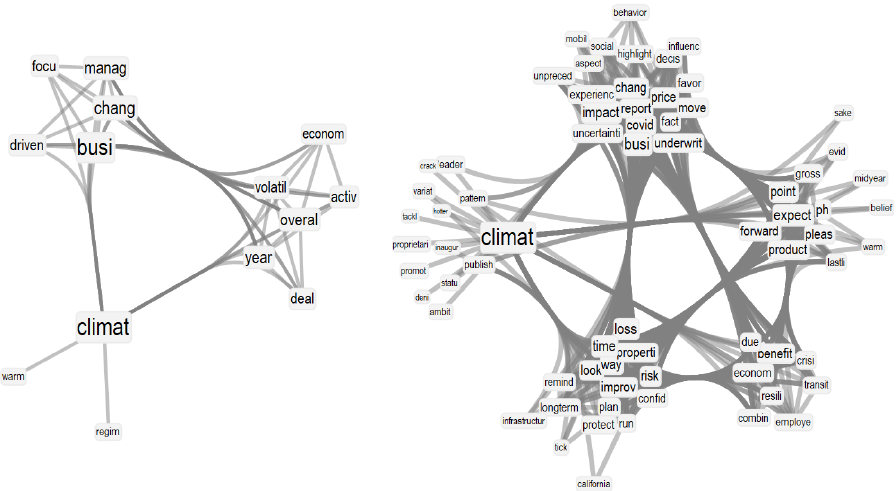
Figure 4. Semantic frame for “climat” in 2018 ( left ) and in 2020 ( right ) insurance reports. Note: node size reflects degree centrality, i.e., the semantic frame size of each word in the overall cognitive network. Words are clustered in Louvain communities only for the sake of visualisation (see also [5]).